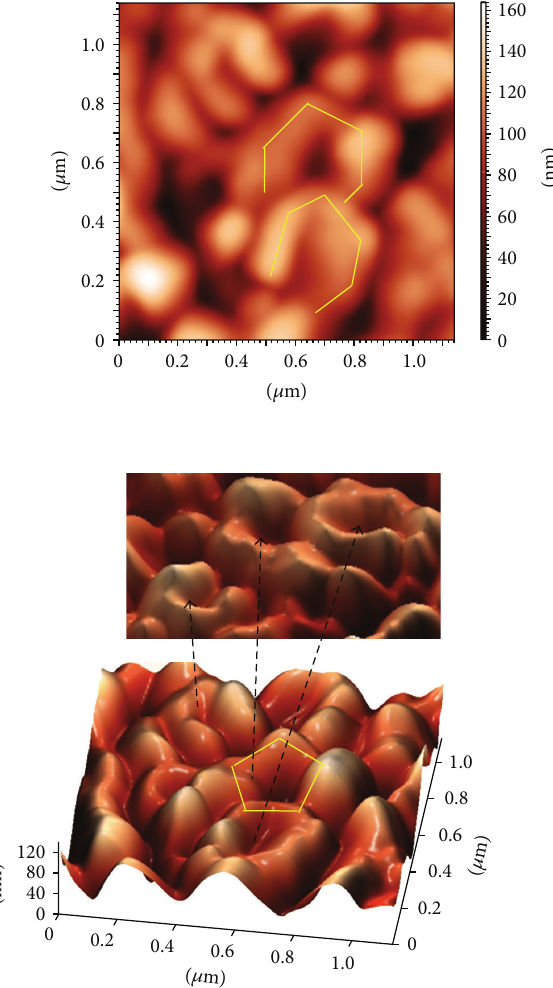
Figure 2: 2D and 3D AFM images of the silver chiral pentagon sculptured thin